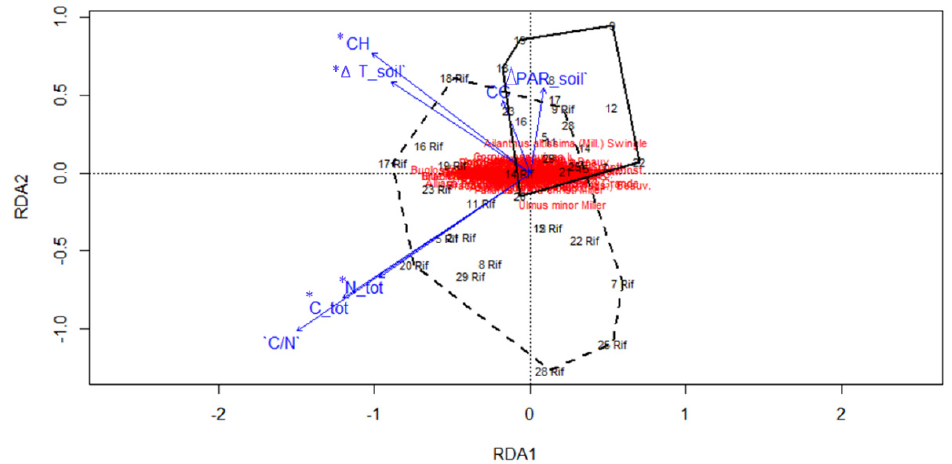
Figure 4. RDA Ordination diagram of vegetation plots and species in relation to the considered environmental variables. A. altissima forests are within the dashed line. Native forests are within the continuous line. Significant variables (at p value ≤ 0.05) are reported with asterisks. RDA1 explains 39.1% of the cumulative amount of variance expressed as proportions of the total explained variance and RDA2 axes as 19.02%. For abbreviations of the variables, see Table 3. Table 2. Redundancy analysis . Ordination parameters of redundancy analysis (RDA). Significance of the environmental factors. p level: *** p < 0.001; ** p < 0.01; * p ≤ 0.05.